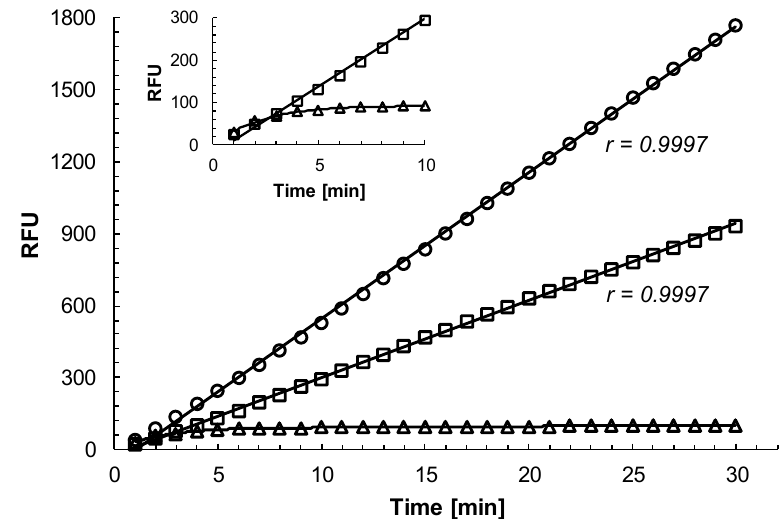
Figure 1. E ff ect of curcumin and CAA0255 on the substrate hydrolysis activity of rhodesain. Purified rhodesain (7 ng / mL; 0.2 nM) was incubated with 6 µ M curcumin (squares), 0.1 µ M CAA0255 (triangles), or with DMSO alone (circles) in 100 mM citrate, pH 5.0, 2 mM dithiothreitol, 2% DMSO in the presence of 5 µ M of the fluorogenic substrate Z-FR-AMC. The release of free AMC was recorded every minute for 30 min. r, correlation coe ffi cient of the trend line. Insert, enlarged detail view of substrate hydrolysis activity of rhodesain in the presence of curcumin and CAA0255 for the first 10 min. A representative experiment out of three is shown.